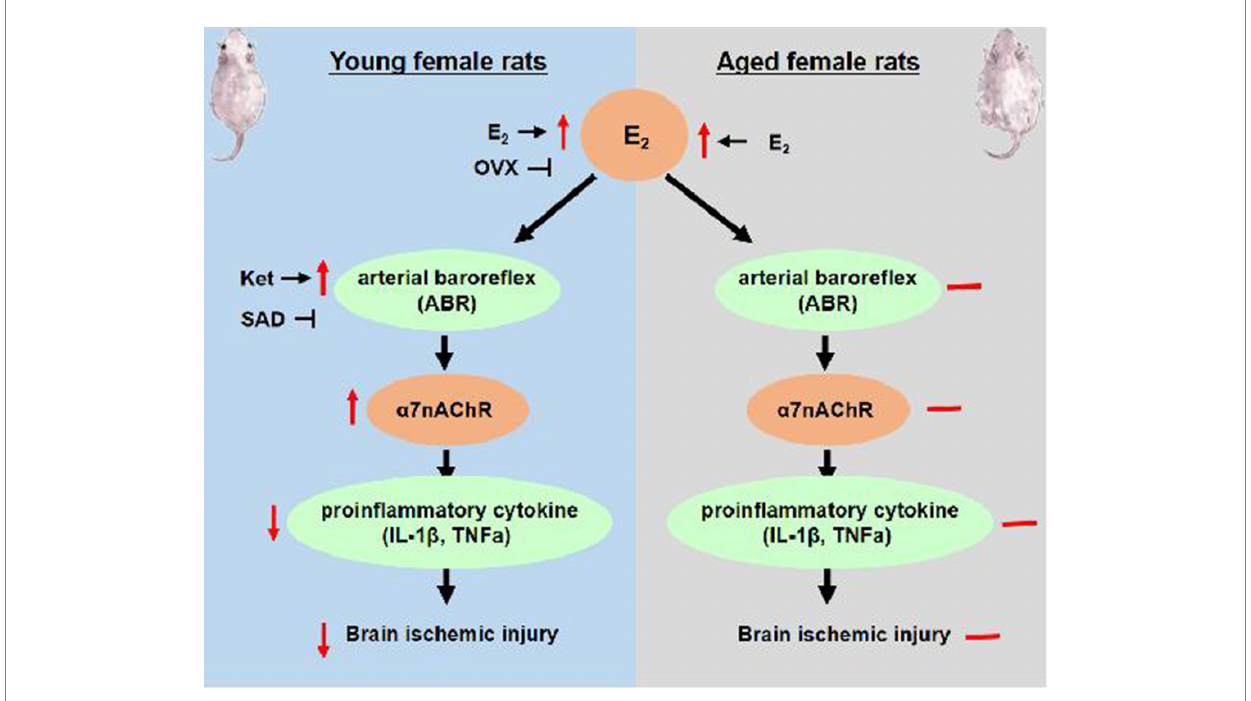
FIGURE 7 The proposed mechanism of age-dimorphic effect of estrogen on brain ischemic injury. E 2 , estrogen; OVX, ovariectomy; SAD, sinoaortic